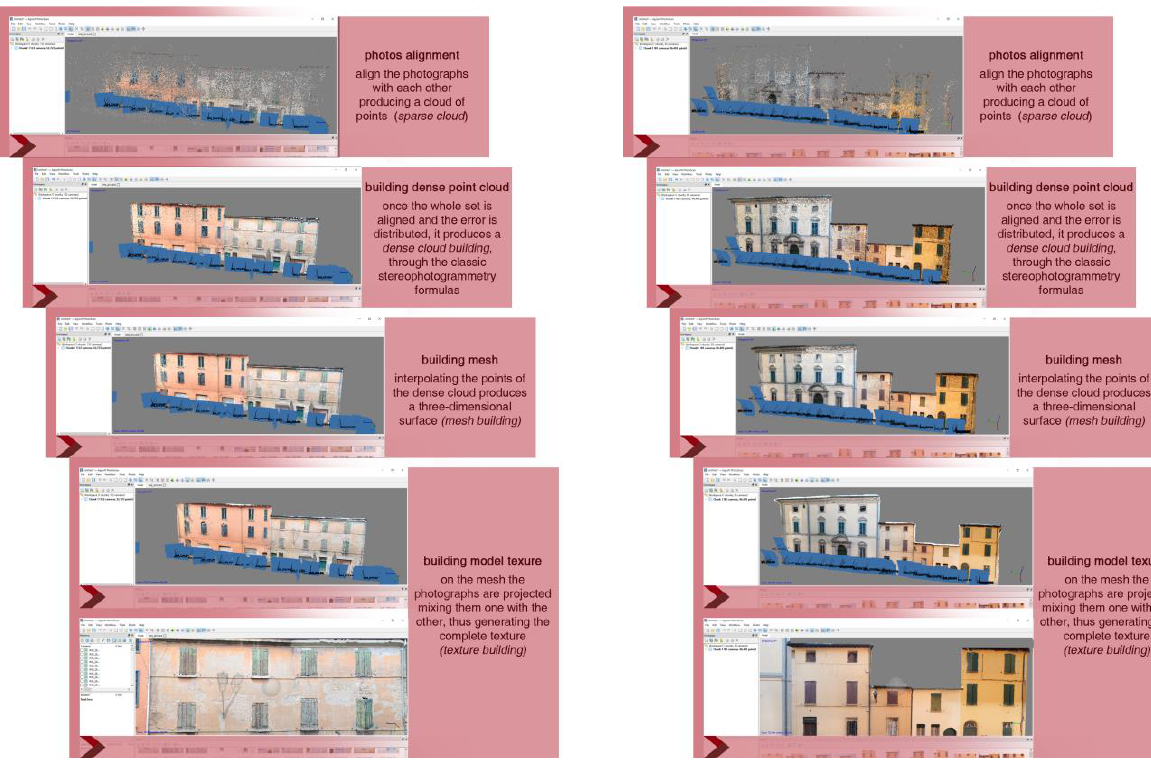
Figure 4. Model creation.